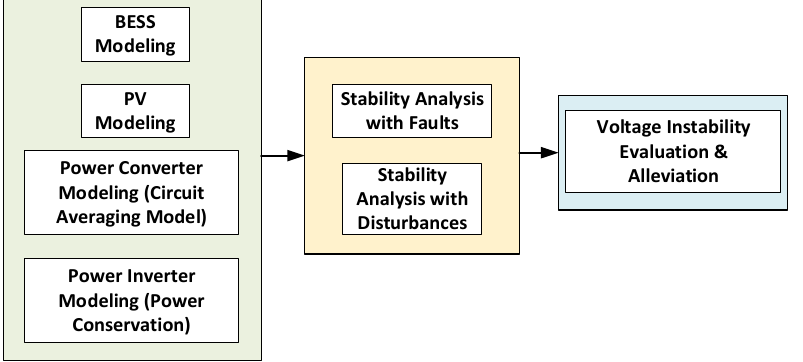
Figure 1. The Workflow of Methodology.